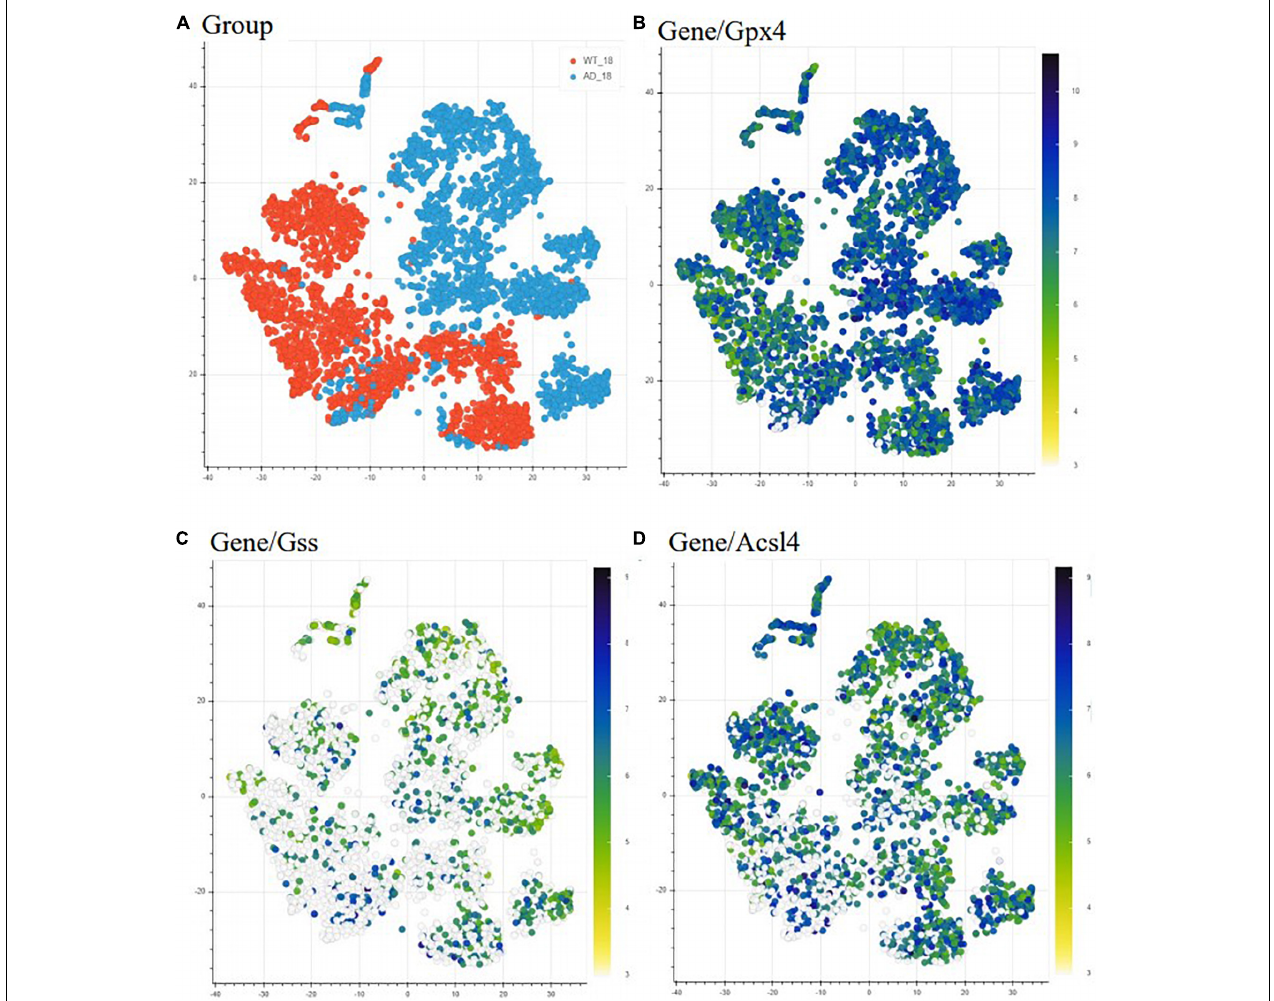
FIGURE 2 | Differential expression of ferroptosis related genes in AD mice model compared to WT mice. Heatmap representing the difference in expression of ferroptosis-related genes between 18 months old WT (orange) and AD mice (light blue) (A) . The heatmap depicts gene expression from low/white to high/dark blue. Each point indicates one spatial transcriptomic spot defining one tissue domain on the slide. Glutathione peroxidase 4 (Gpx4) is upregulated with pathology (B) , while glutathione synthase (Gss) (C) and acyl-CoA synthetase long-chain family member (Acsl4) (D) are downregulated with the pathology. This data is freely accessible online, Alzmap (Chen et al.,